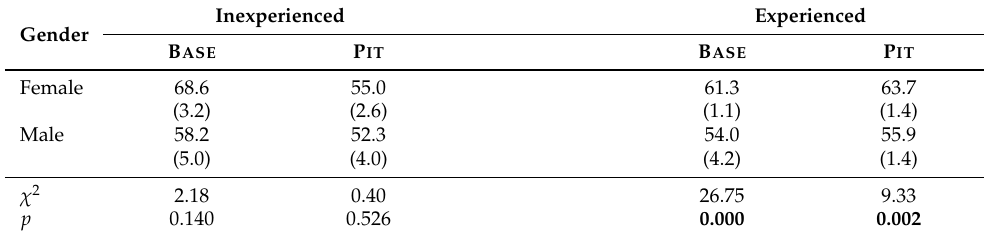
Table A6. Responder’s Probability to Accept an Offer of 30 Tokens.